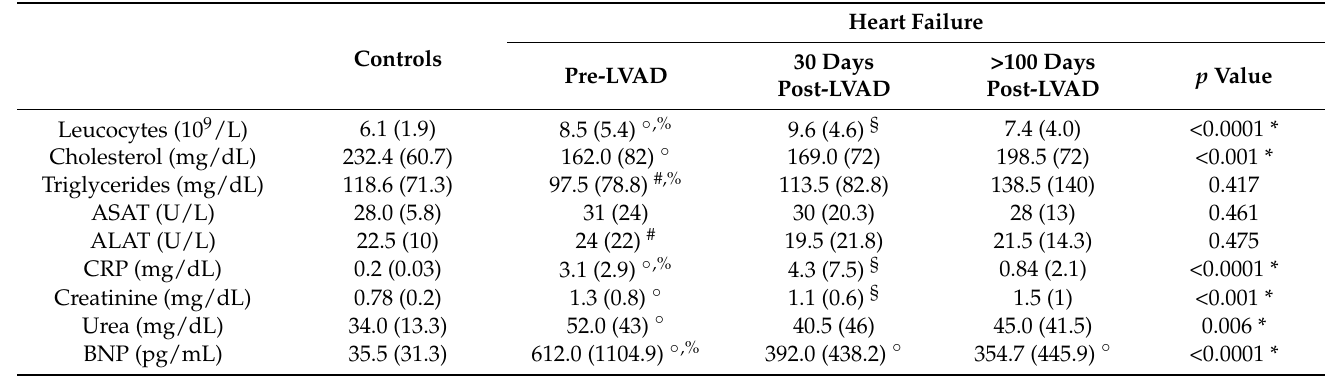
Table 2. Laboratory